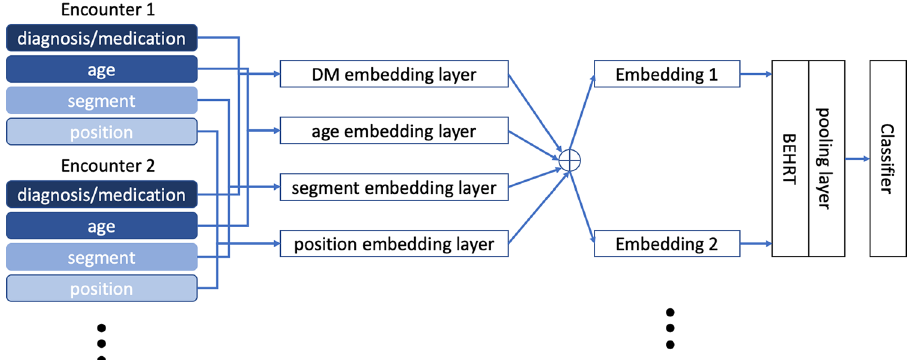
Figure 5. Model architecture. The model includes an embedding layer to encode the input features, a feature extractor based on BEHRT, and a classifier for prediction. DM represents diagnosis and medication; the pooling layer only extracts the latent representation of the first encounter (time step) for